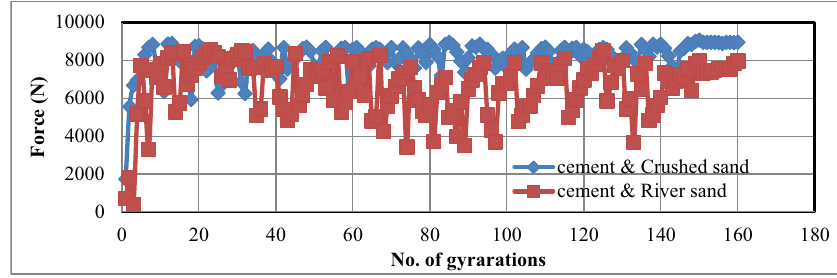
Figure 6: The measured force on the sample obtained from the modi fi ed gyratory apparatus using cement as fi ller.